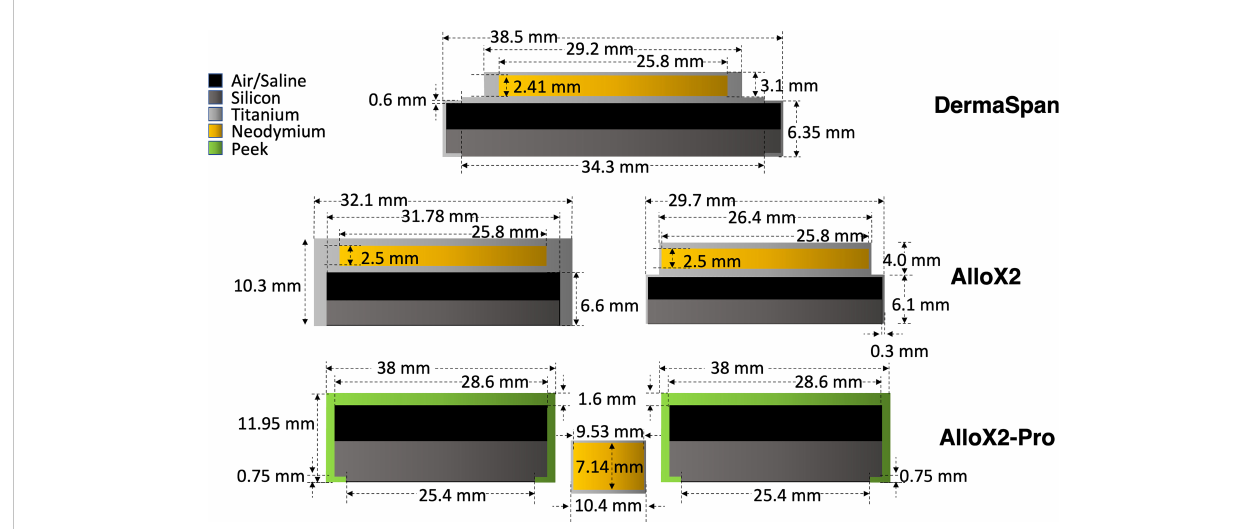
FIGURE 1 Drain/injection ports for the three temporal breast tissue expanders studied in this